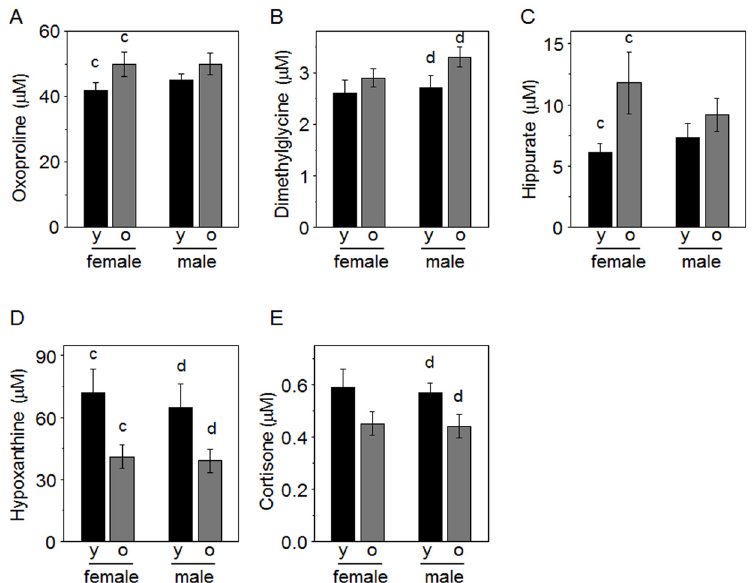
Fig 5. Metabolites differing by age in marmosets. Female and male marmosets were grouped according to age as younger (y, 2 to 7 y) and older (o, 8 to 15 y). A-C, metabolites higher in older than younger. D and E, metabolites higher in younger than older. Following ANOVA, post-hoc tests showed differences between groups as indicated: c, younger versus older females; d, younger versus older males. Group sizes were: females, 12 y, 12 o: males 13 y, 13 o.